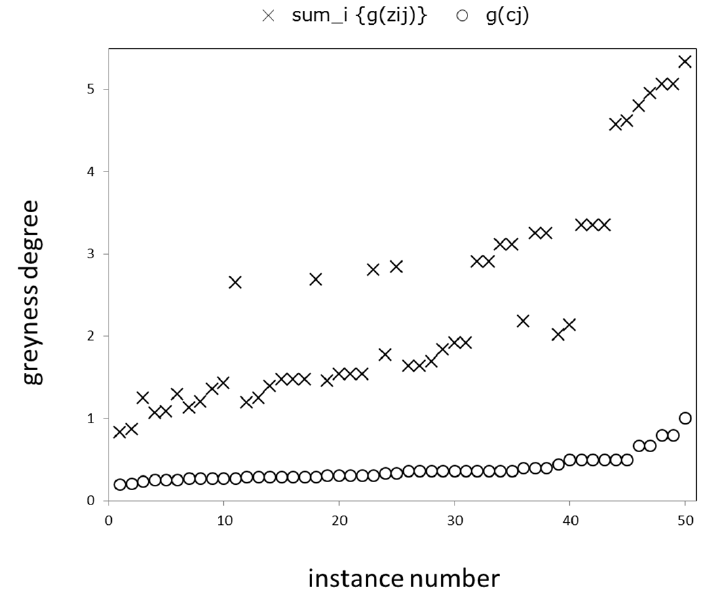
Figure 1. Greyness degree results for summation.